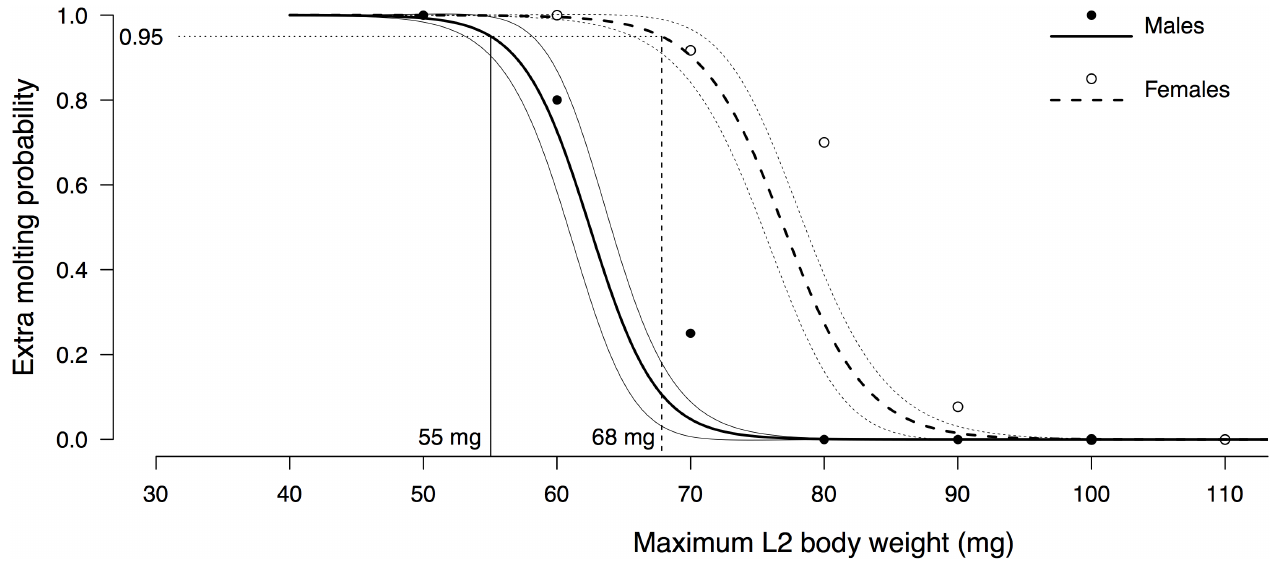
Fig 3. Extra molting probability for each sex as a function of L2 maximum body weight. Circles (filled for males and open for females) represent the proportion of extra molting observed in groups of individuals every 10mg of maximum L2 body weight. Curves (continuous for males and dashed for females) represent the fit (and associated standard error) of the following GLM logistic regression model: (extra molting)~ (maximum L2 body weight):(sex) (backwardly-selected by AIC). The horizontal dotted line shows the 95% probability above which individuals undergo an extra molt. Vertical lines show the corresponding body weight thresholds for each sex, i.e. the 2nd-instar body weight under which the predicted extra-molting probability exceeded 95%: 55mg for males and 68mg for females.